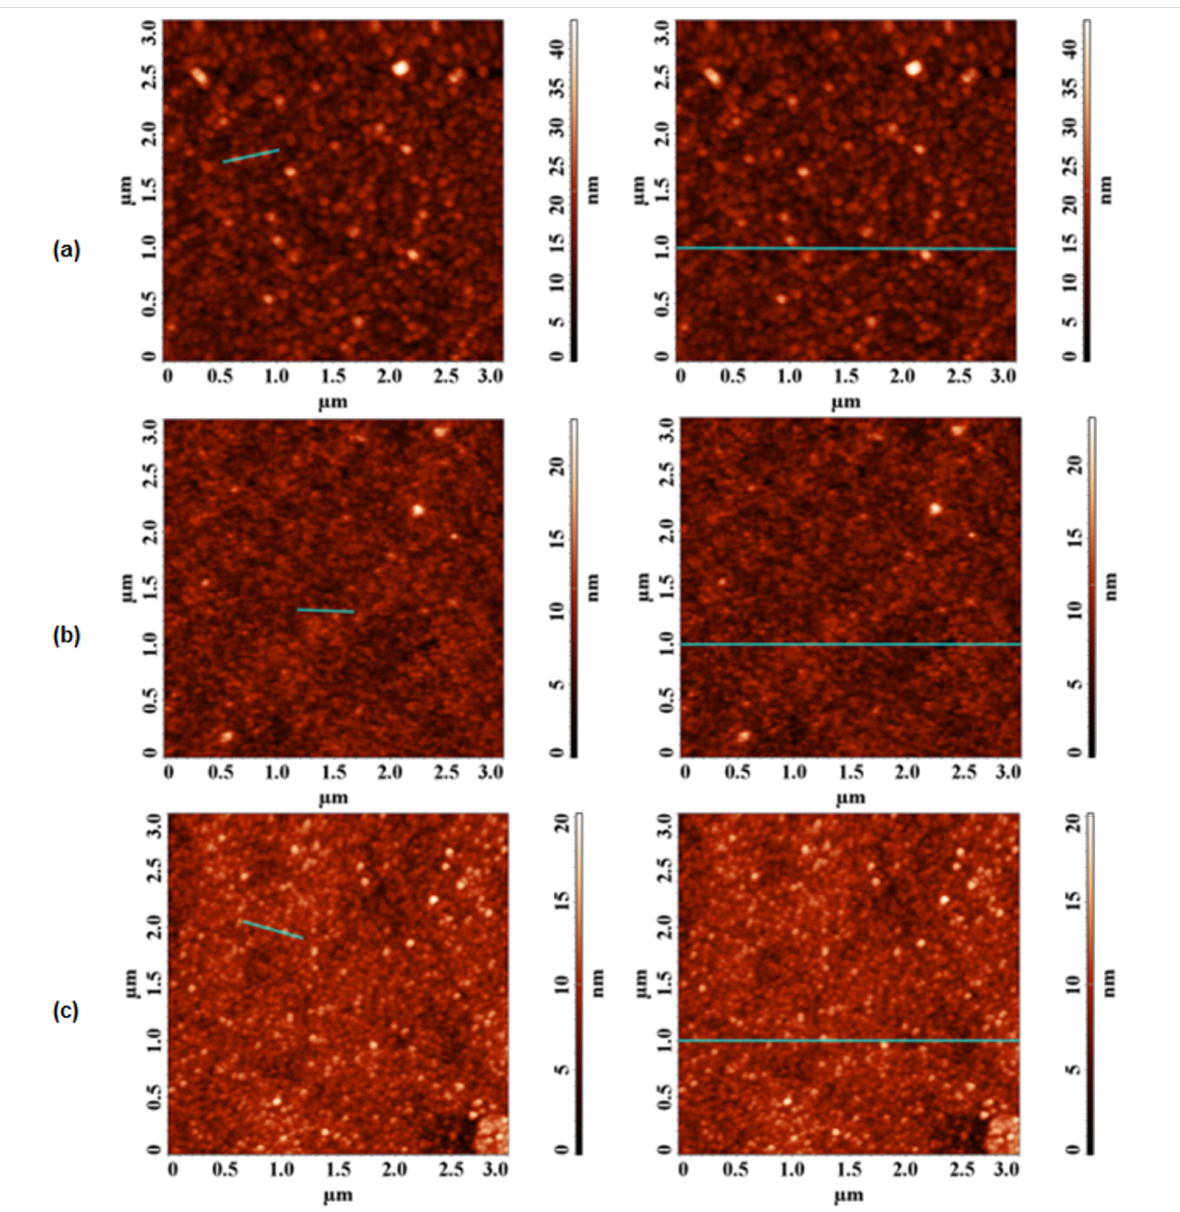
Figure 5: Representative AFM images obtained over 3 × 3 µm 2 areas of the non-rotaxane 3 (a), 3 · TM- β CD (b) and 3 · TM- γ CD (c) polyrotaxanes.